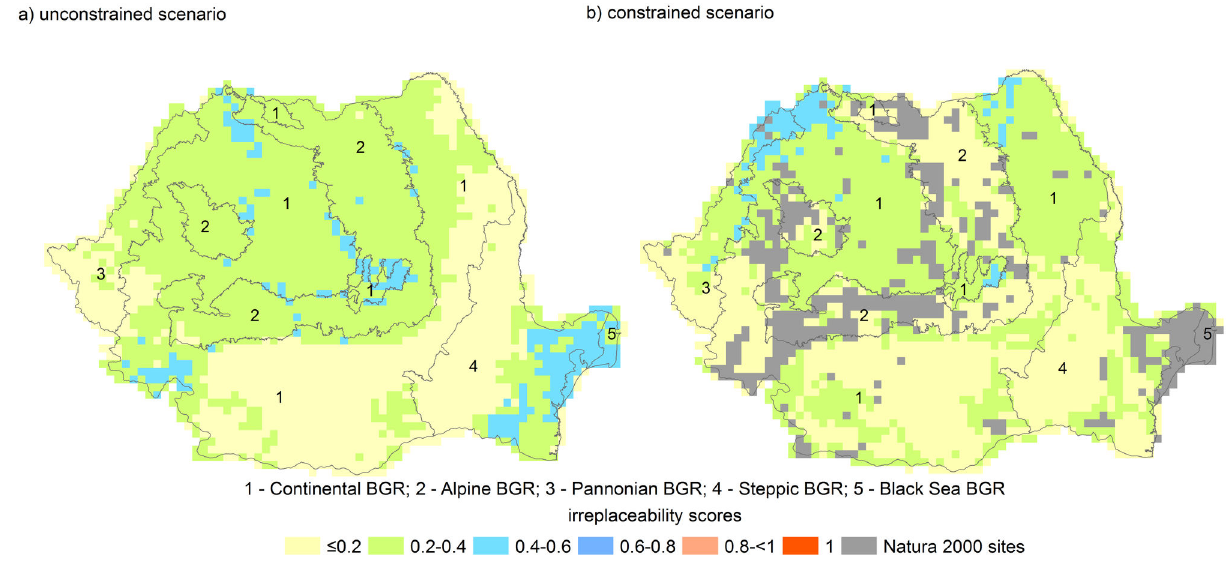
Figure 4. Planning unit (PU) irreplaceability scores under (a) unconstrained PU availability scenario (all PUs available for selection), and (b) constrained PU availability scenario (all currently protected PUs are given a score of 1). For (a), areas in blue represent priority areas for reptile and amphibian conservation regardless of their protection status. When all current SCIs are considered highly irreplaceable (b), northwest Romania becomes a conservation priority. doi: